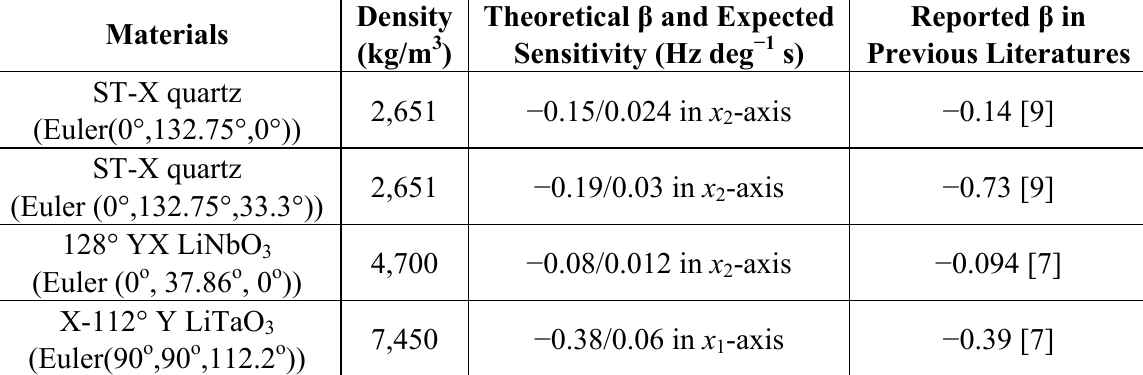
Table 2. The calculated gyroscopic effect for SAW along various